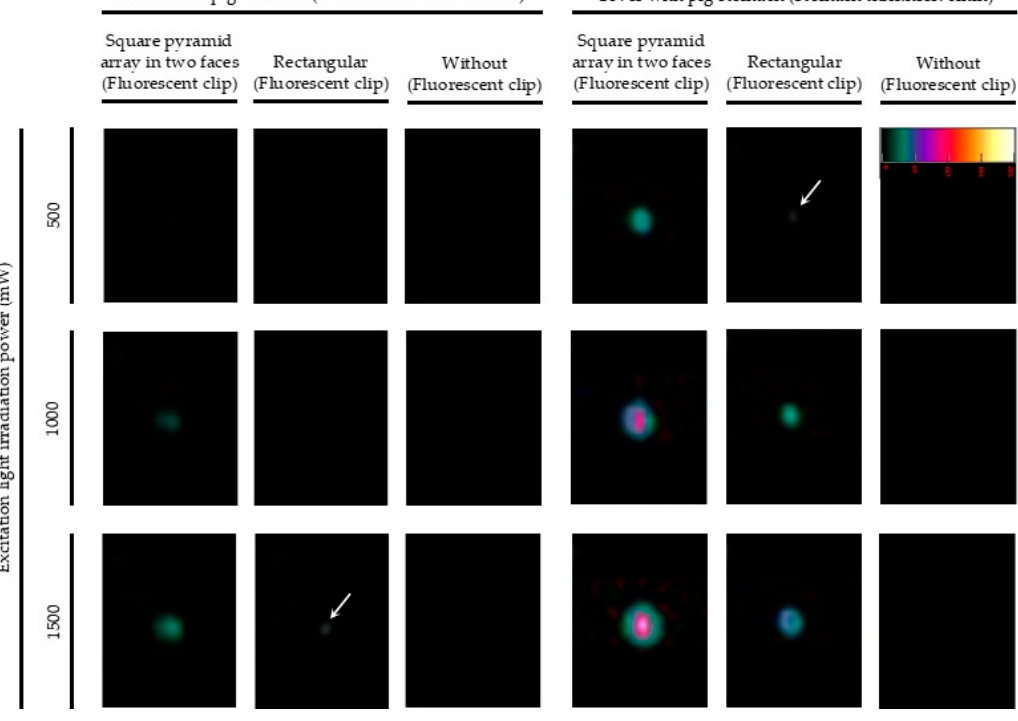
Figure 5. Detection of the fluorescent clips fixed in a commercially available pig stomach sample. The fluorescent image of the clip with the square-pyramid-array-in-two-faces, glass phosphor structure was successfully obtained with good fluorescence output. Micromachines 2019 , 10 , x FOR PEER REVIEW